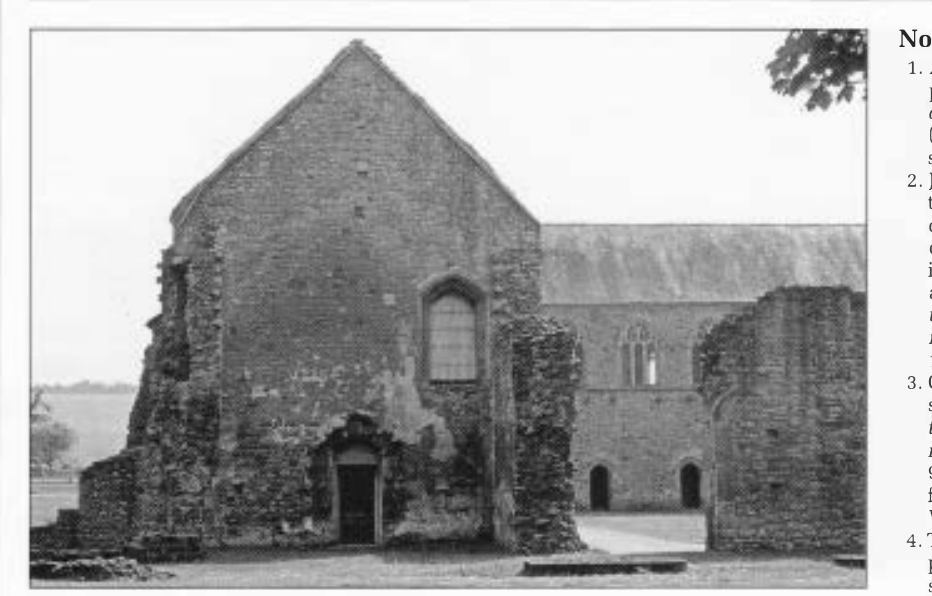
Figure 4 Cleeve Abbey, Somerset: the exterior of the sacristy and cloister viewed from the north, 1998. nitely, and so it is possible that a supersat­ urated solution can reach equilibrium with its surroundings at RH values below that at which crystallization would nor­ mally be predicted to take place. Thus, it appears that salt-crystallization inhibitors may help to reduce the incidence of salt damage in objects exposed to a fluctuating